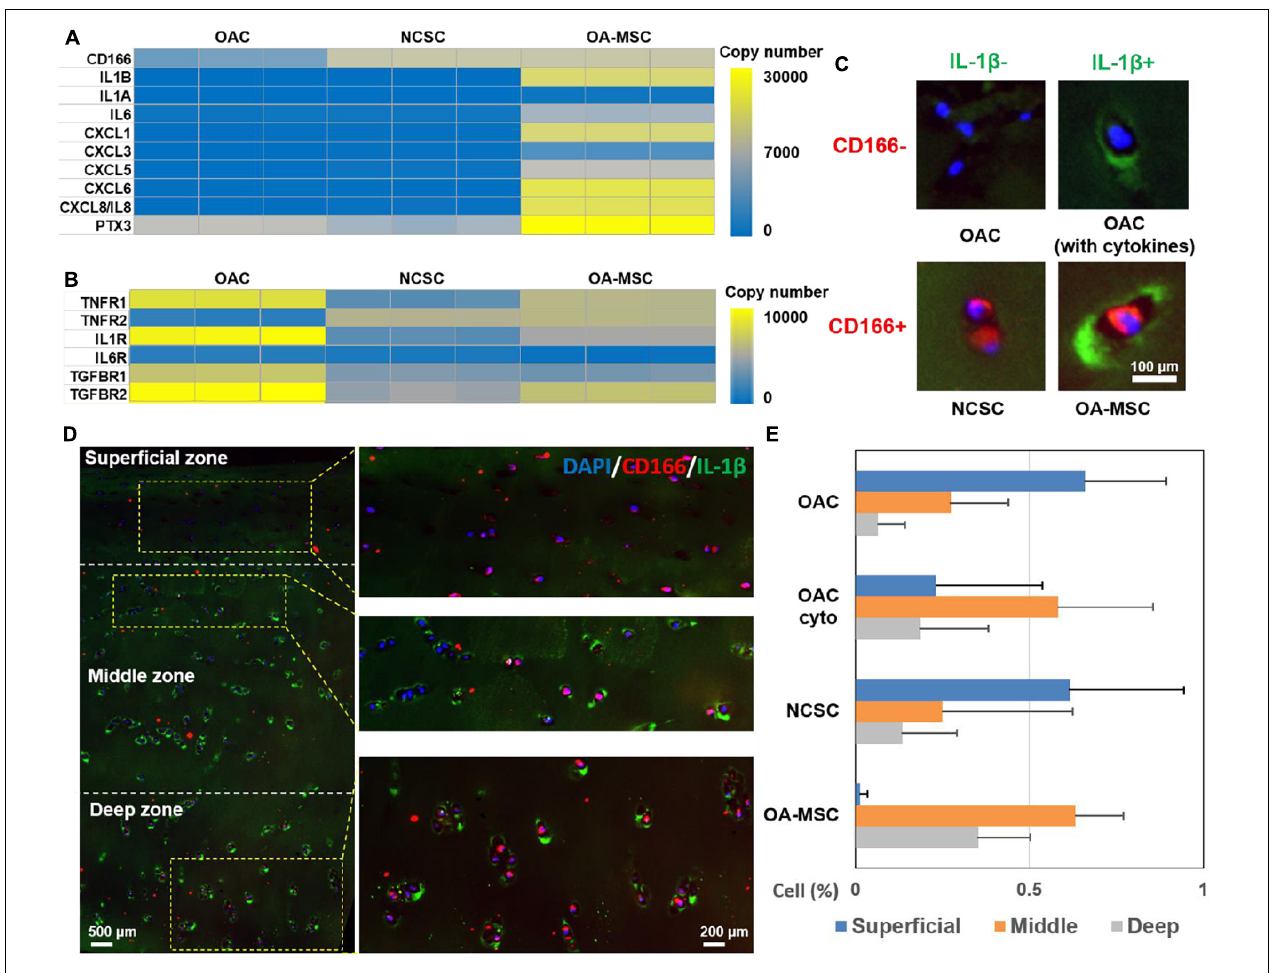
FIGURE 6 | Identification of OAC, NCSC-like cells, and OA-MSC in human OA articular cartilage. (A) Differential expression analysis of cytokine, chemokine, and related genes in OAC, NCSC, and OA-MSC. RNAseq analysis was performed with OAC, NCSC3, and OA-MSC2 samples ( n = 3). Yellow color represents higher copy number up to 10,000, while blue color represents lower copy number down to 0. Gray color represents intermediate copy number. Note that while IL-1 β was synthesized by OA-MSC, neither OAC nor NCSC synthesized IL-1 β . (B) Differential expression analysis of cytokine and chemokine receptors and related genes in OAC, NCSC, and OA-MSC. RNAseq analysis was performed with OAC, NCSC3, and OA-MSC2 samples ( n = 3). Yellow color represents higher copy number up to 30,000, while blue color represents lower copy number down to 0. Gray color represents intermediate copy number. (C) Immunofluorescence analysis of different types of cells in human OA cartilage. While chondrocytes are CD166 - , mesenchymal stromal cells are CD166 + . OAC does not synthesize IL-1 β but binds to IL-1 β because it expresses IL-1R. OAC is CD166 - /IL-1 β - ; OAC binding to IL-1 β (OAC with cytokine) is CD166 - /IL-1 β + , NCSC-like cell is CD166 + /IL-1 β - , and OA-MSC is CD166 + /IL-1 β + cells in OA cartilage. CD166 was labeled by rhodamine red conjugated secondary antibody. IL-1 β was labeled by green fluorescein conjugated secondary antibody. The nucleus was stained with blue Hoechst dye. (D) The double immunofluorescence histochemical analysis of CD166 and IL-1 β in different zones in human OA articular cartilage. CD166, a marker of MSC, was indicated by rhodamine-conjugated secondary antibody (red). IL-1 β , a marker of SASP was indicated by fluorescein-conjugated secondary antibody (green). The nucleus was stained with DAPI (blue). (E) The percentages of OAC, OAC (with cyto), NCSC-like cells, and OA-MSC in different zones of human OA articular cartilage ( n = 3). Statistical analysis was presented in Supplementary Table 3